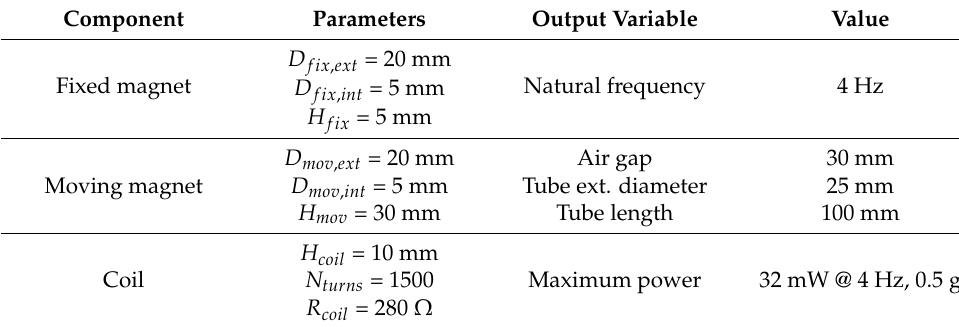
Table 9. Parameters and performances of the optimized energy harvester.